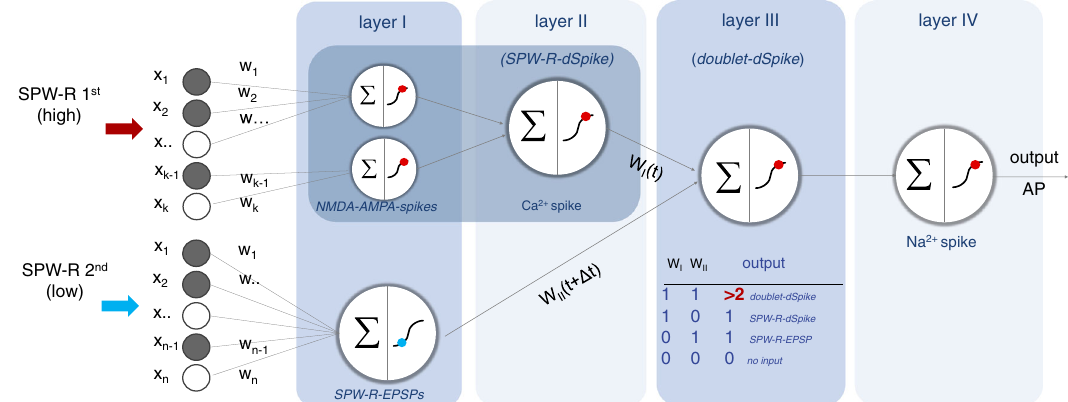
Fig. 5 | Schematic of dendritic non-linear computation in PV+ interneurons during SPW-Rs and SPW-R doublets. Our model comprises four supralinear lay- ers, which covert information from dendritic inputs ( x i ) to the somatic output (outputAP)duringthetwoeventsofSPW-R-doublets(SPW-R1st,SPW-R2nd).Layer I: local dendritic activation above (NMDA-AMPA spikes) and below (SPW-R-EPSPs) the threshold of NMDA-AMPA spikes. Layer II: dendritic Ca 2+ spikes (SPW-R- dSpikes), which appear on top of NMDA-AMPA spikes. Layer III: SPW-R doublet-